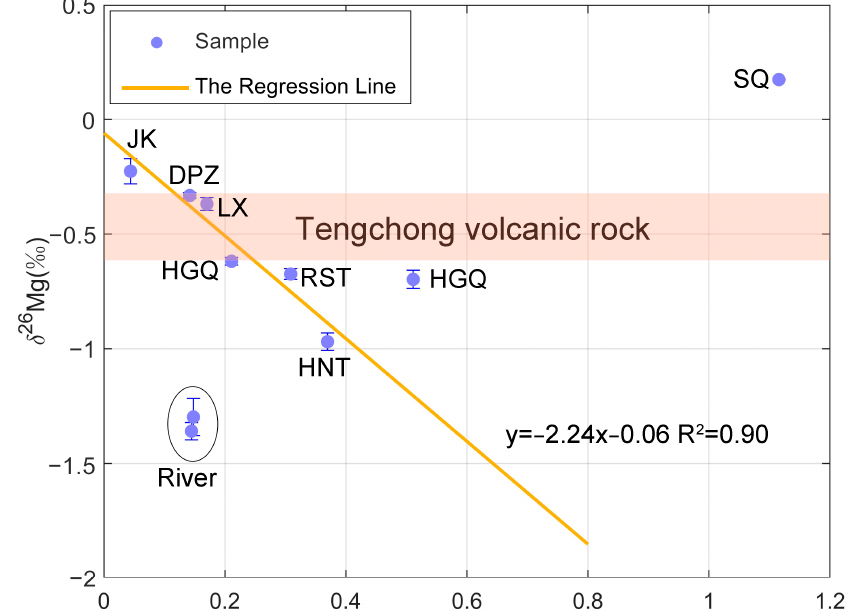
Figure 5. Variations of δ 26 Mg values with Mg concentrations in the Tengchong hydrothermal fluids. The δ 26 Mg values of most of the samples decrease with increasing Mg concentration. SQ is more specific, exhibiting higher Mg concentration and δ 26 Mg values.